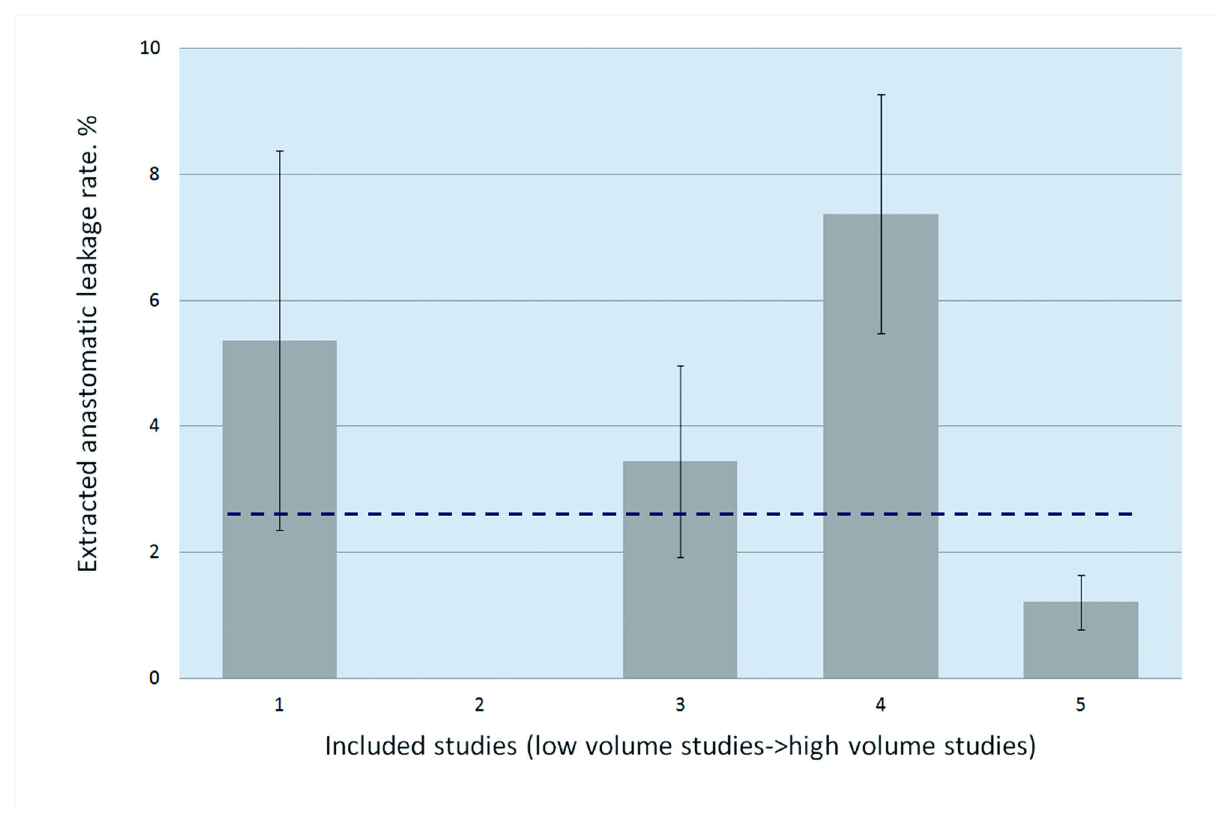
Figure 3. Extracted rates of Grade A leakage ranked by